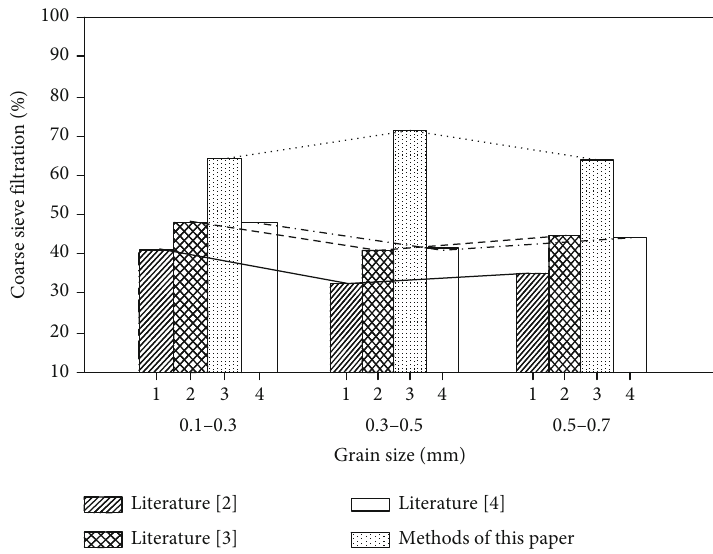
Figure 5: Experimental results on coarse-grade sieve fi lter